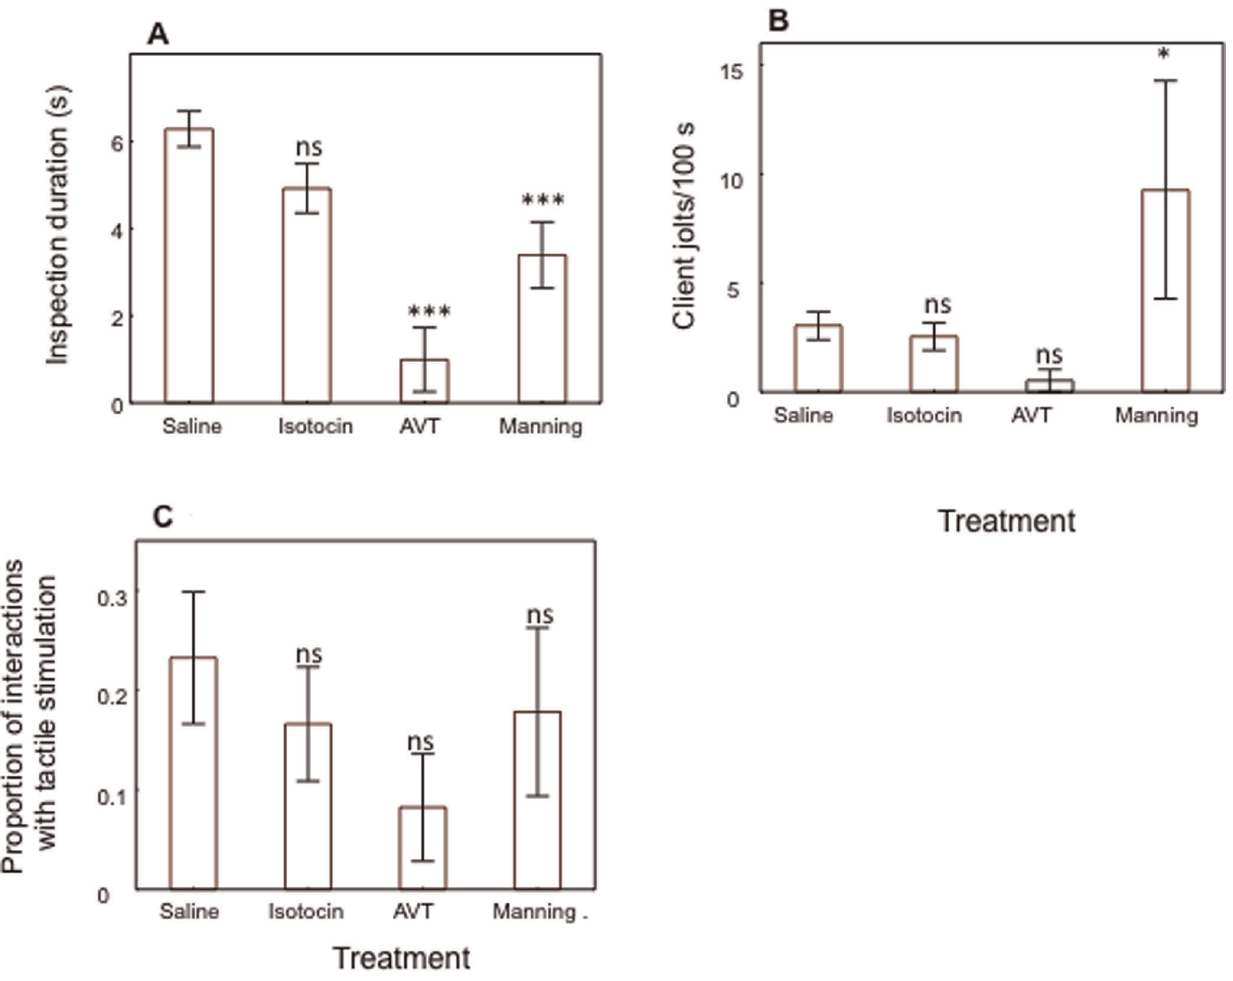
Figure 2. Field neuropeptide effects on measures of cleaner fish Labroidesdimidiatus interspecific cleaning service quality. A) client inspection duration at cleaning stations (in seconds), B) number of client jolts per 100 s of inspection and C) proportion of interactions in which tactile stimulation was applied to clients (number of cleaning events in which cleaner performed tactile stimulation/total number of cleaning events). Means are shown 6 1 SEM. Symbols above bars and sample sizes per treatment were the same as in Figure 1.